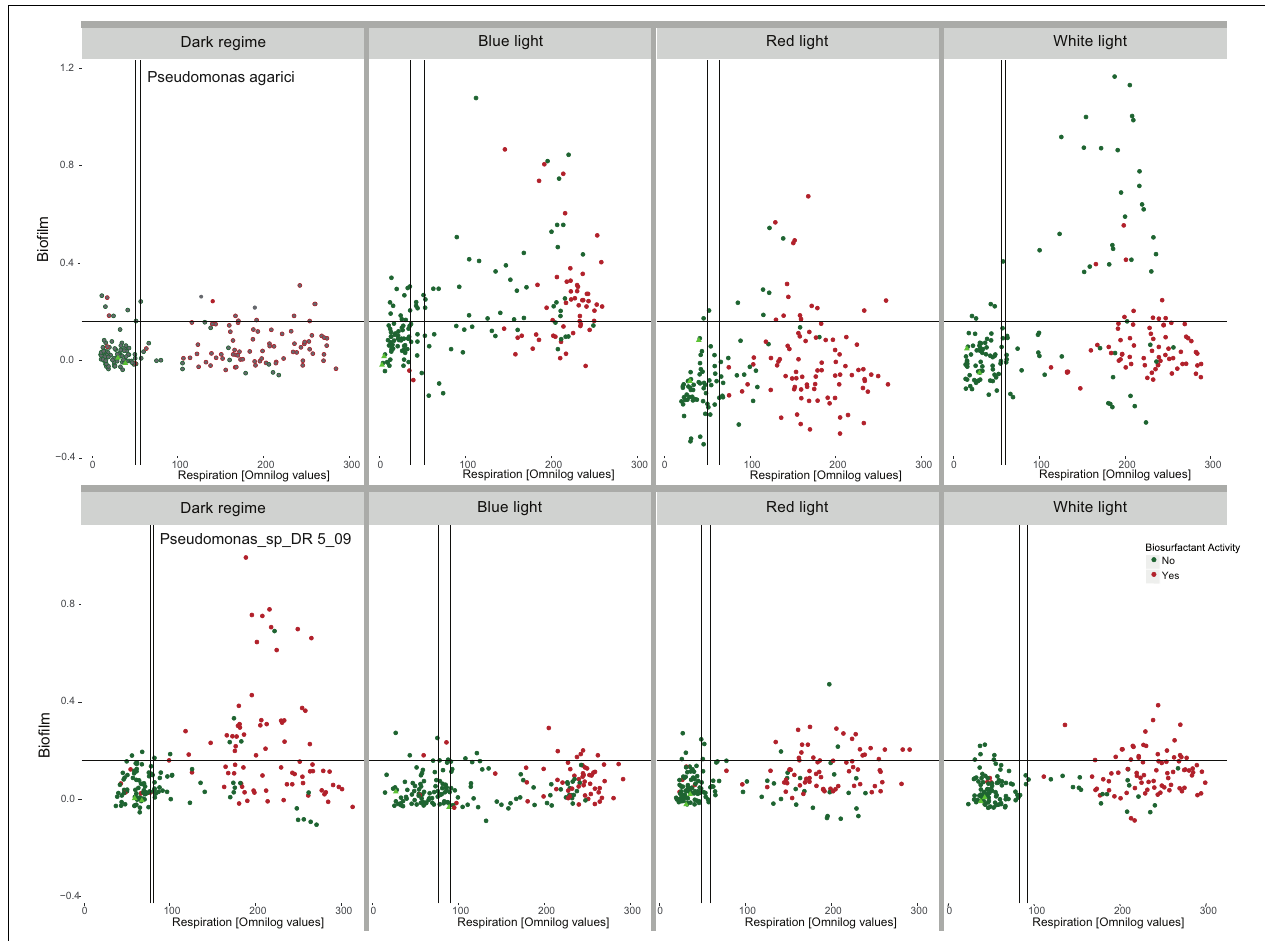
FIGURE 7 | Interactions between light regime (dark incubation, incubation in the presence of short waved blue and long waved red monochromatic LEDs as well as polychromatic white LEDs), respiration of 190 C-sources by Pseudomonas agarici and Pseudomonas sp. DR5-09 and biofilm formation quantified at incubation endpoint. Green and red dots indicate the absence and presence, respectively, of endpoint biosurfactant activity in the individual wells. The experiment was conducted with two replicate panels using Omnilog phenotypic microarray (PM1 and